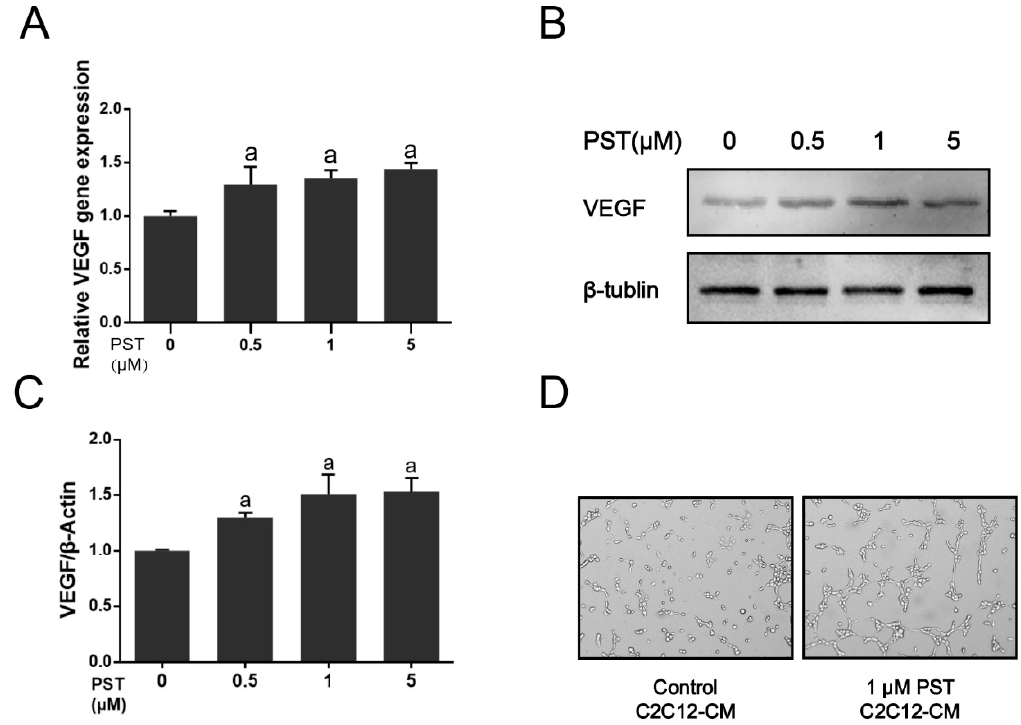
Figure 5. Effects of pterostilbene (PST) treatment on muscular angiogenesis in vitro. Gene expressions ( A ), representative western blotting bands ( B ), and their quantitative analysis ( C ) of VEGF in C2C12 myotubes treated without or with 0.1–5 µ M PST. Tube formation assay test of murine endothelial cells ( D ). SVEC4-10 cells were treated with conditioned media (vehicle or 1 µ M PST treated C2C12 myotubes) for 3–4 h. Similar results were obtained from 3–6 experiments. Protein expression levels were normalized to the expression of β -tubulin. Data are expressed as mean ± SD, a— p < 0.05 compared with the control group.